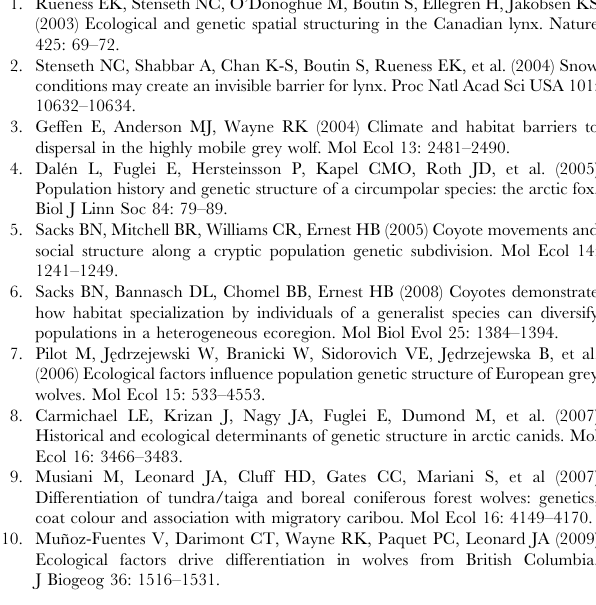
Figure S1 Distributions of posterior estimates of pro- portional contributions of prey sources in diet of Eastern European wolves inferred from the stable isotope data using MixSIR for: four subpopulations delimited based on mtDNA variability (MIT 1-MIT 4), two subpopulations delimited based on microsatellite variability (NUC 1, NUC 2), and the entire population. Figure S2 IsoSource dietary mixing polygon for Eastern European grey wolves. The wolf d 13C and d 15N values are plotted with potential prey. Trophic enrichment values of 1.3 % for d 13C and 4.6 % for d 15N (from Fox-Dobbs et al. 2007) were added to the mean d 13C and d 15N values of potential prey. Stable isotope profiles are presented as mean and standard deviation for the wolf and each prey species. Table S1 Sample information and d 15N and d 13C isotope profiles ( % ) for 110 Eastern European wolves analyzed in this study.